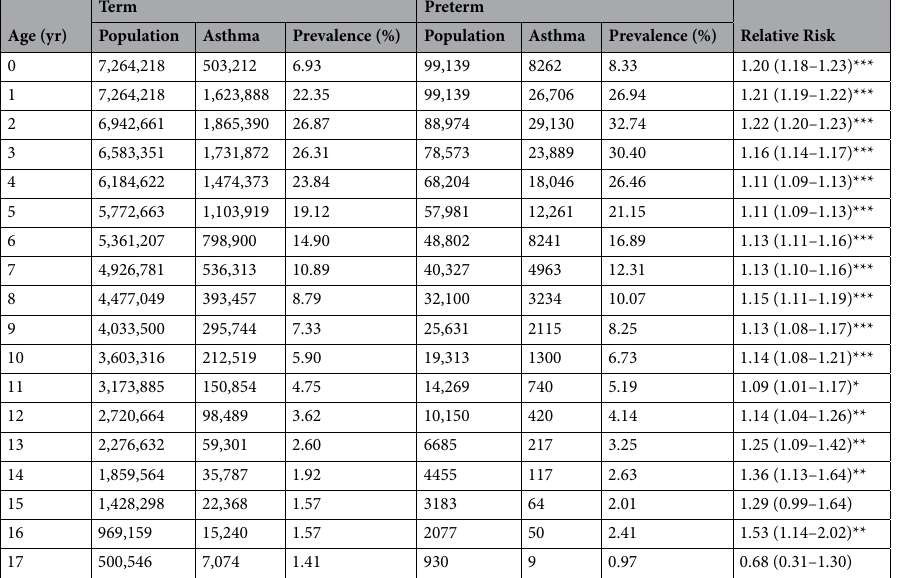
7.57 for preterm infants. At the age of 15 years, the number of prescribed asthma-related medications was 4.6 for term infants and 7.05 times for preterm infants. Asthma‑related drug prescription rates and risk factors in preterm infants. An additional analy- sis was performed to determine the risk factors for asthma in preterm infants (Table 2). Among the preterm infants, the number of all asthma-related prescriptions according to demographic factors or comorbidities was evaluated. Preterm male infants with asthma, relative to their female counterparts, had a significantly increased risk (RR: 1.1, 95% confidence interval [CI] = 1.09–1.12) for the prescription of asthma medication. Preterm infants with extreme prematurity and other preterm infants had a 1.92-fold (95% CI = 1.82–2.03) and 1.57-fold (95% CI = 1.51–1.63) increase in prescriptions for asthma, respectively, relative to that of moderate/late pre- term infants. A 1.80-fold increase was observed in the risk for prescriptions for asthma medications in infants with extremely low birth weight (RR: 1.80, 95% CI = 1.68–1.94) and a 1.43-fold increased risk in infants with